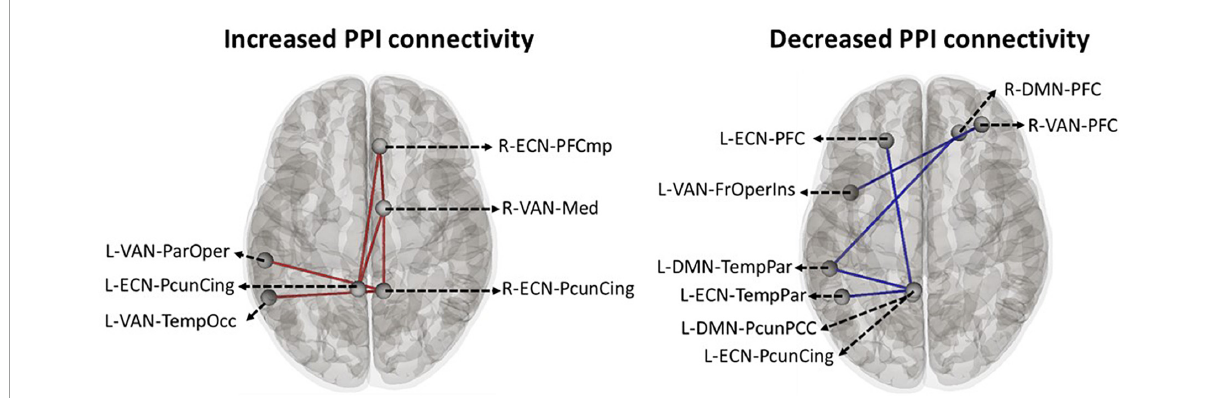
FIGURE5 Time by intervention interaction in PPI connectivity within and between large-scale network nodes: Exploratory ROI-to-ROI gPPI results. Task-based modulation in connectivity with time x intervention interaction ( P uncorrected < 0.05) between the main node of three large-scale networks in the Yeo atlas, including ECN, DMN, and VAN. Within the network, task-based modulation in connectivity did not survive correction using the FDR method. A small dot is an indicator of the main node of a large-scale network. ECN, frontoparietal network; DMN, default mode network; VAN, ventral attention network; FrOperIns, frontal-operculum-insula; Med, medial; ParOper, parietal-operculum; PFC, Prefrontal cortex; TempOcc, tempro-occipital-parietal; TempPar, tempro-parietal; PcunCing, precuneus cingulate; PcunPCC, precuneus posterior cingulate cortex; R, right side; L, left side; blue line, a decreased PPI connectivity between to ROIs in active tDCS while it increased in sham, red line: an enhanced PPI connectivity between two ROIs in active tDCS, while it decreased in the